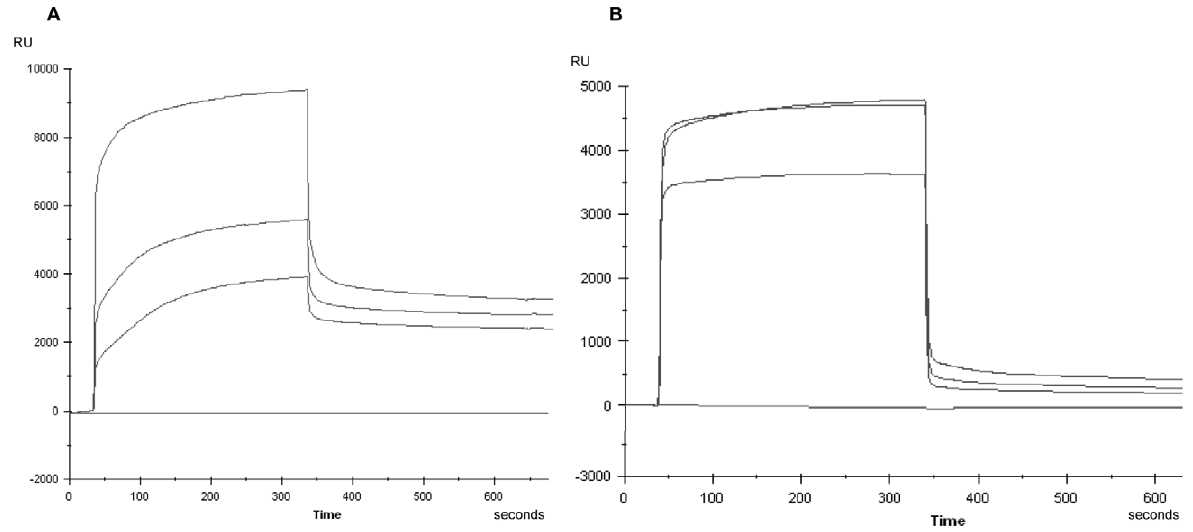
Figure 4. Representative sensorgrams. Panel (A): sera from a childhood-onset diabetic patient and panel (B): sera from an adult-onset diabetic patient.